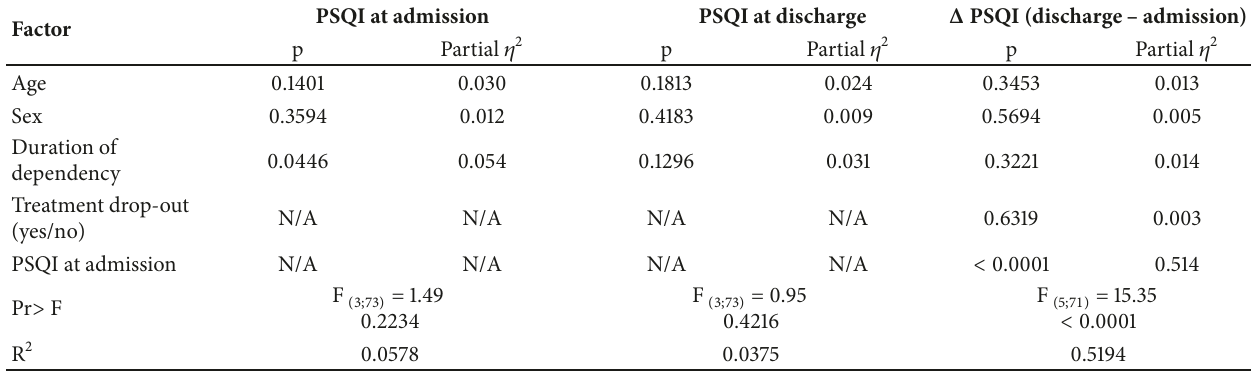
Table 2: General linear model for prediction of PSQI at admission, discharge, and PSQI change during treatment.